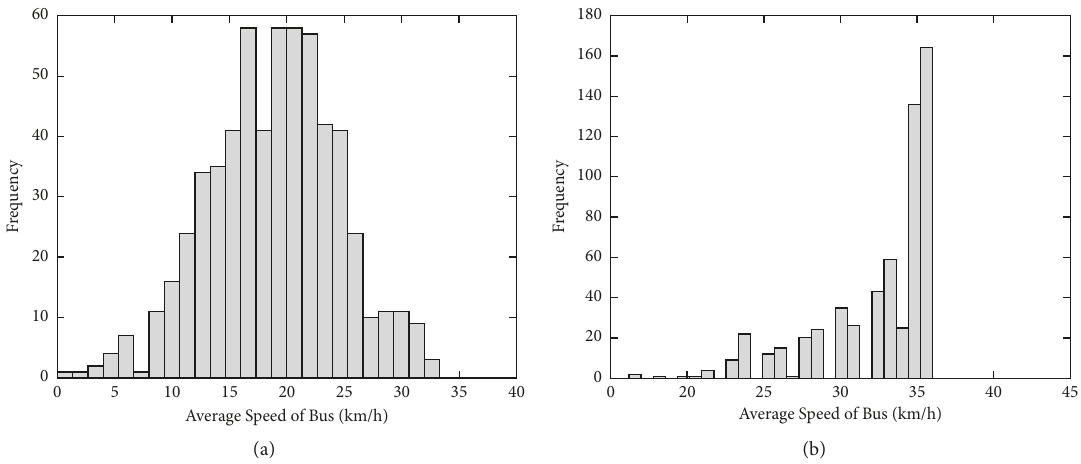
Figure 8: Histograms of average bus speed. (a) Histograms of average bus speed in Group A. (b) Histograms of average bus speed in Group B.